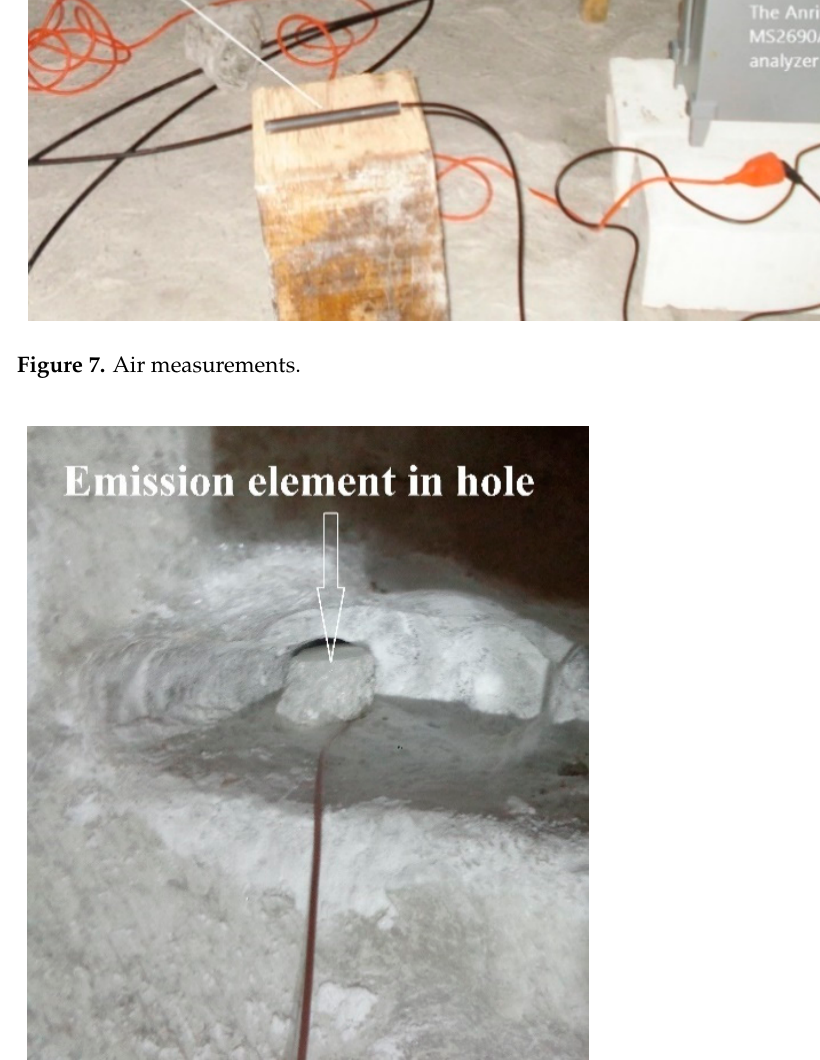
Figure 9. Reception electromagnetic sensor introduced in saline environment for vertical plane.